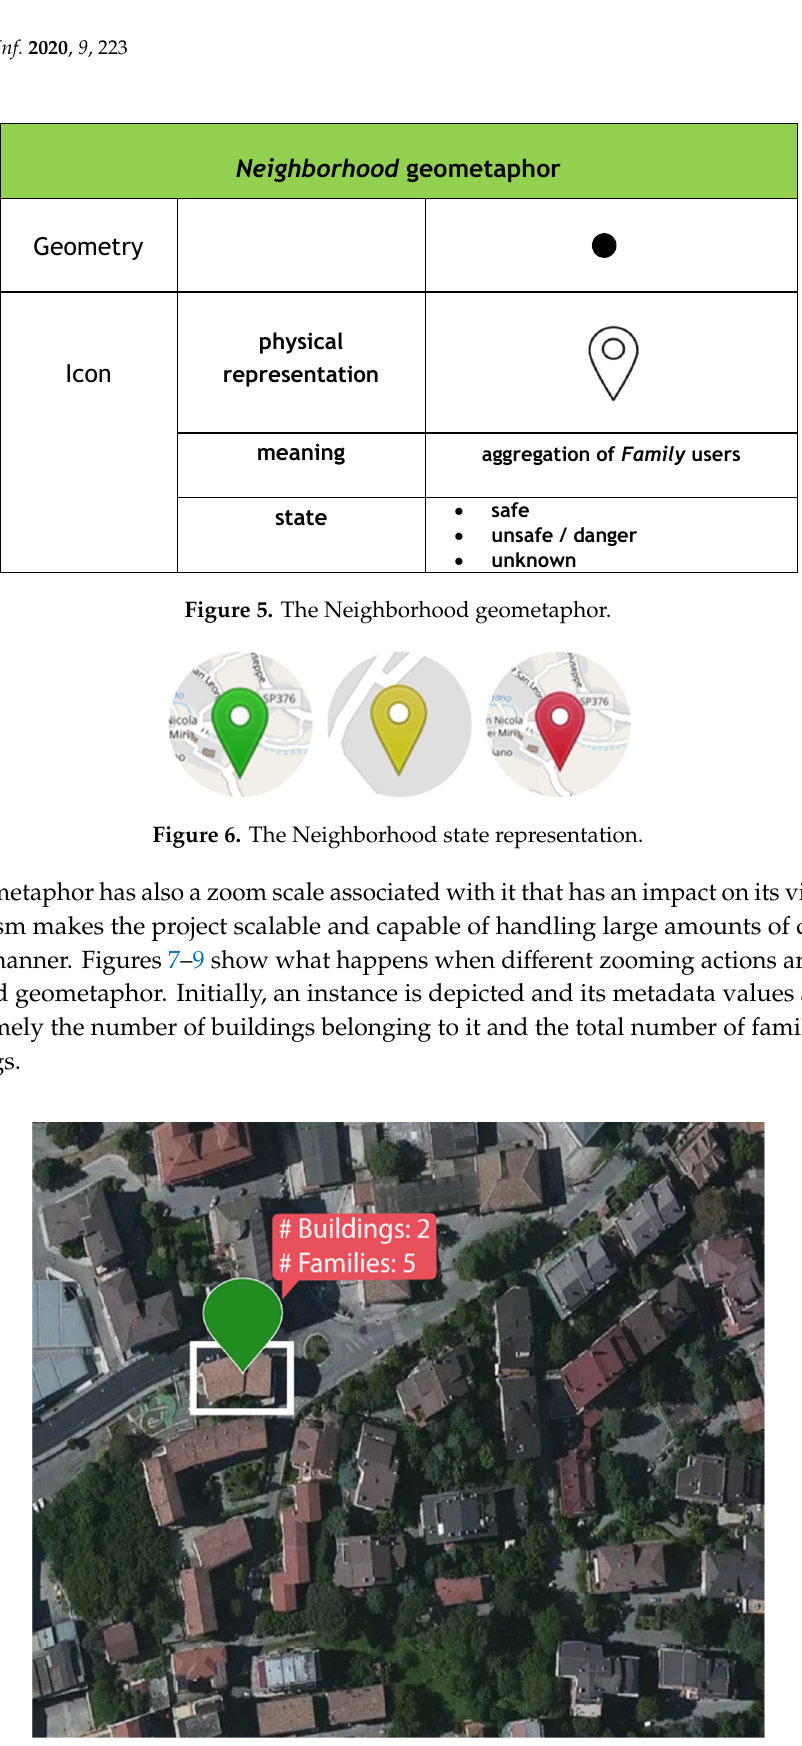
Figure 7. An instance of the Neighborhood geometaphor.